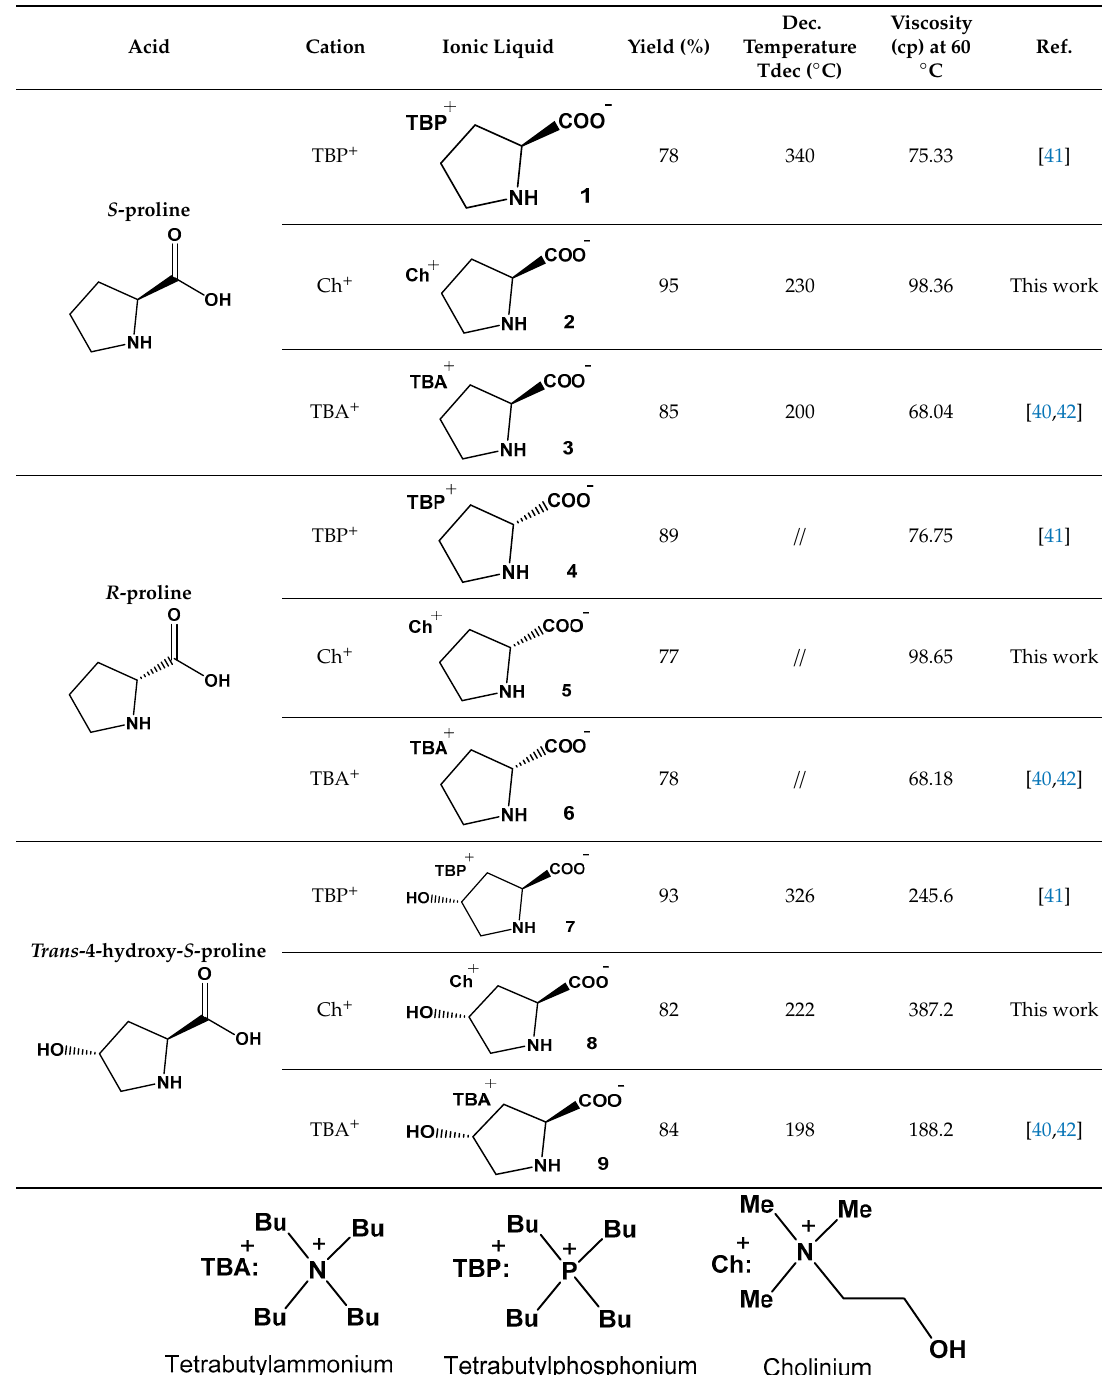
Table 1. Synthetized ionic Table 1. Synthetized ionic liquids. Table 1. Synthetized ionic liquids. Table 1. Synthetized ionic liquids. Table 1. Synthetized ionic liquids. Table 1. Synthetized ionic liquids. Table 1. Synthetized ionic liquids. Table 1. Synthetized ionic liquids. Table 1. Synthetized ionic liquids. Table 1. Synthetized ionic liquids.